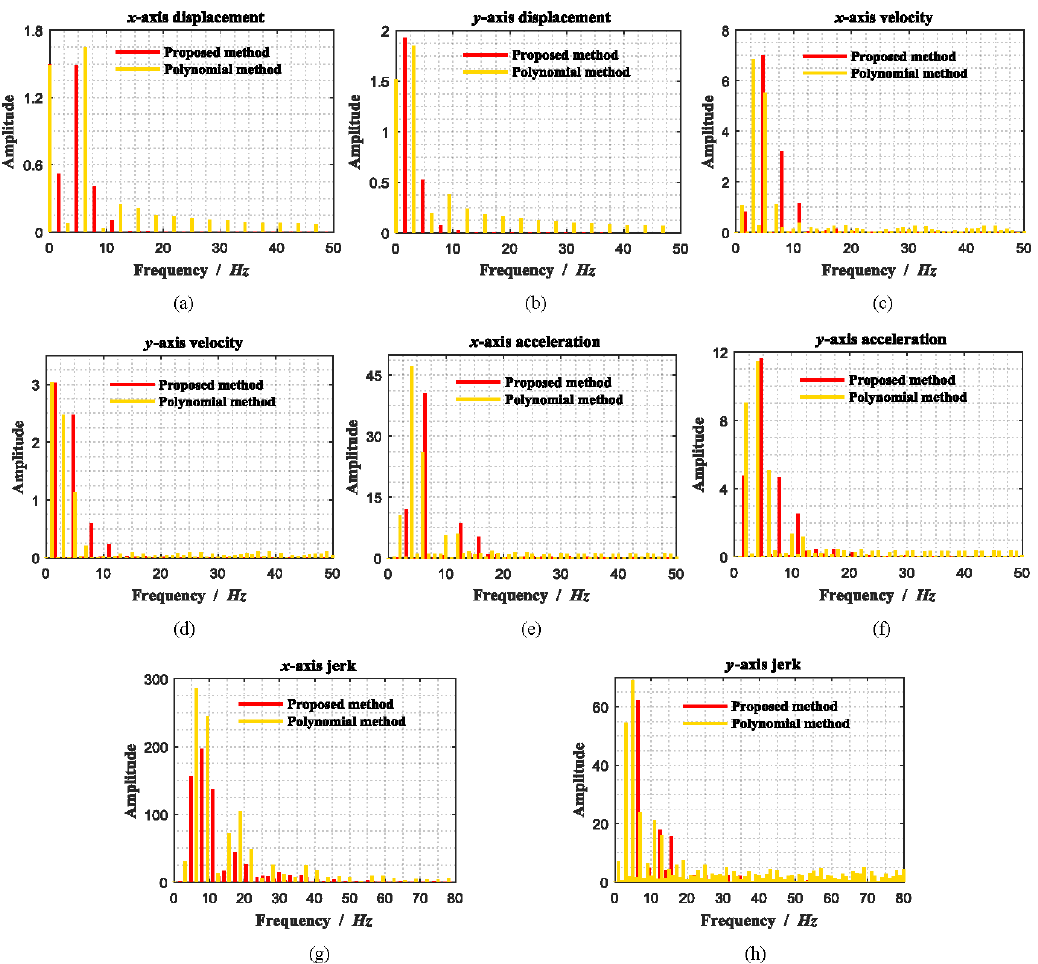
Figure 6. Comparison of the Fourier analysis: (a) x -axis displacement profiles, (b) y -axis displacement profiles, (c) x -axis velocity profiles,